Question: Express in one sentence what the figure is showing.
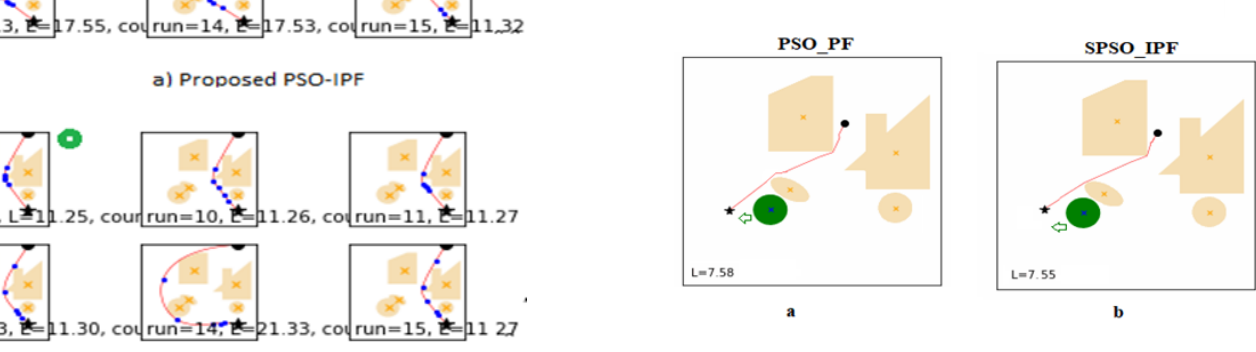
Answer: illustrates SPSO_IPF performance in a complex  environment, consisting of both static and dynamic obstacles  and it compares with the non-Smooth PSO_IPF approach  [15].